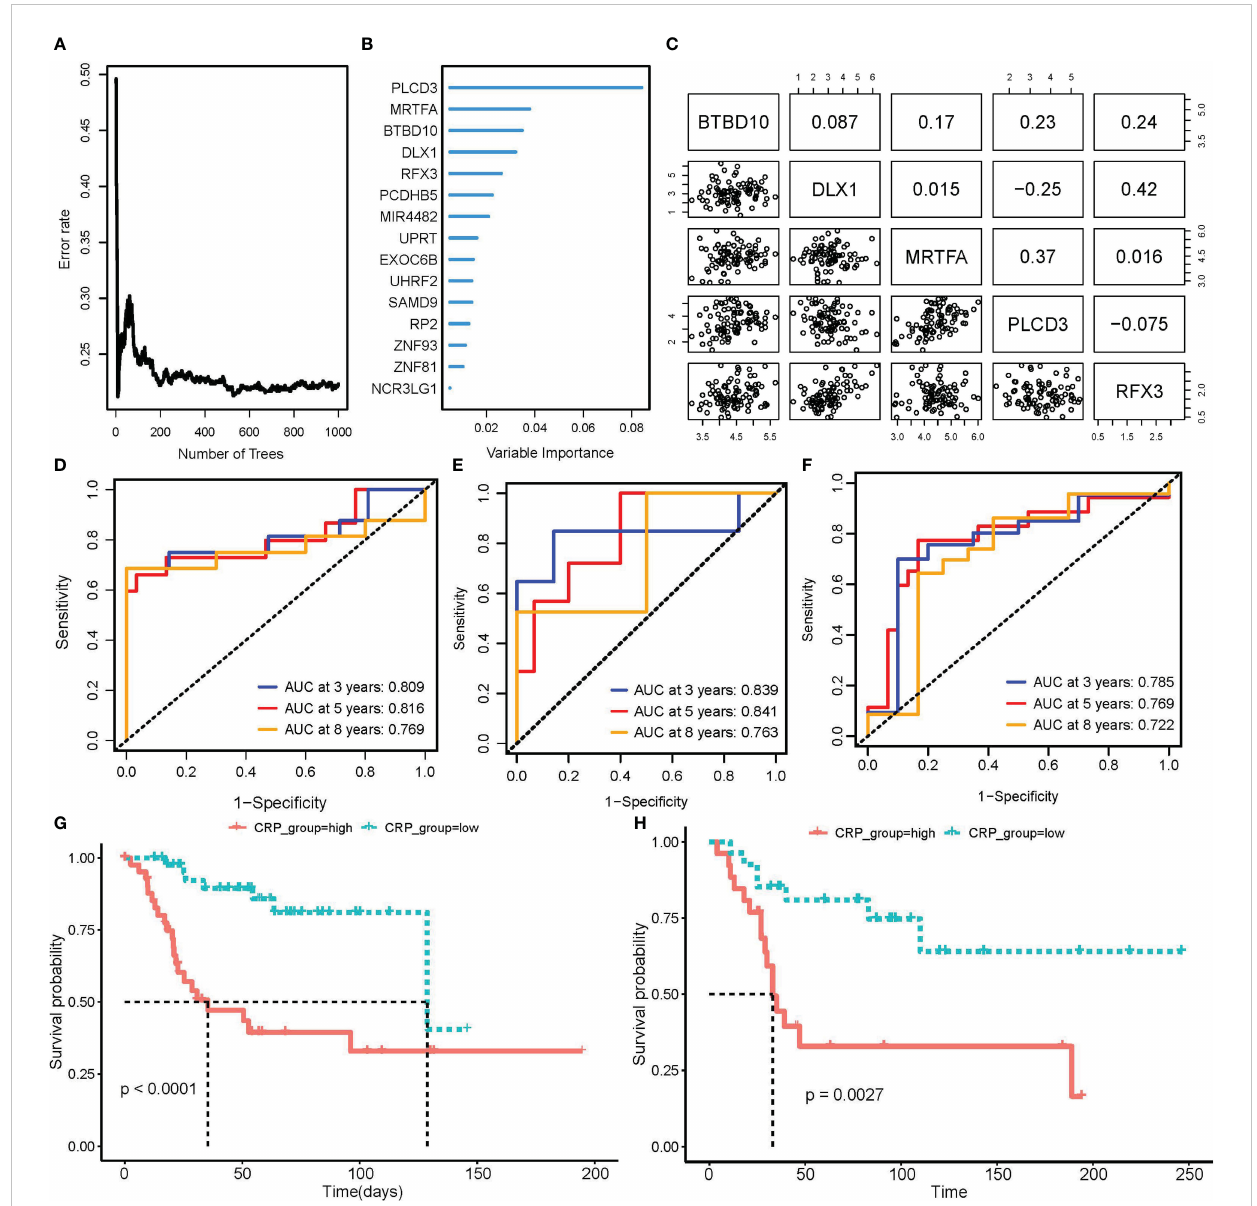
FIGURE 4 Construction and validation of CRP score model. (A, B) RSF model training and variable selection; (A) error rate trends as the number of trees increased when training RSF model; (B) Variable importance of selected features. (C) Correlation of expression in 5 genes that RSF selected to train CRP score model. (D – F) Time-dependent ROC curve to test the predictive ability of CRP score for OS patients in TARGET_OS train set (D) , test set (E) , as well as GSE21573 external validation set (F) . (G, H) K-M curve of CRP scores high and low subgroups for patients ’ overall survival in TARGET_OS (G) and GSE21573 (H)